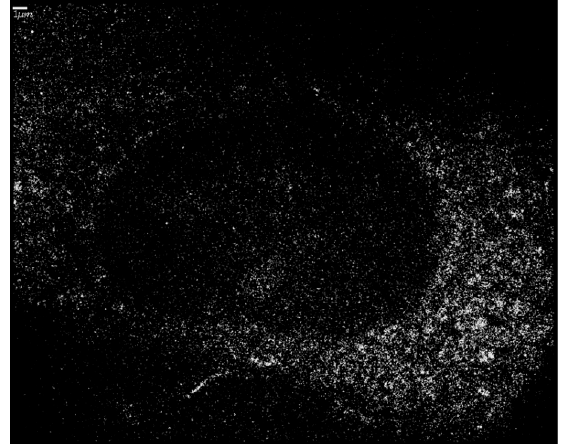
Figure 5. Automated analysis of the extent of γ H2AX + 53BP1 focus (DSB) induction and repair kinetics compared for HeLa cells irradiated with 4 Gy of γ -rays in presence (0.5 mM for 6 h) or absence of 2.6 nm Pt-NPs. The average and median numbers of co-localized γ H2AX+53BP1 foci (i.e., DSBs) per nucleus are shown for different periods of time PI, together with the focus number distributions in each cell population. The boxes include 50% of the values (25th to 75th percentile) centered on the median (the horizontal line through the box). The mean values are represented by the squares within the boxes. The outliers were identified according to the 1.5*IQR method (IQR = interquartile range). Pt—samples treated with platinum nanoparticles, m—the period of time after irradiation in minutes, 0 m—non-irradiated samples.